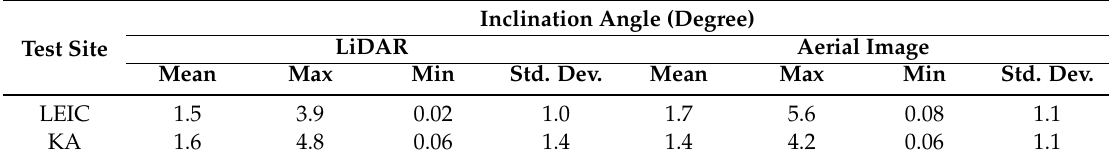
Table 5. Differences between inclination angle of the extracted roof planes and their corresponding reference planes for both data types and test sites (Leicester = LEIC, Karlsruhe = KA).